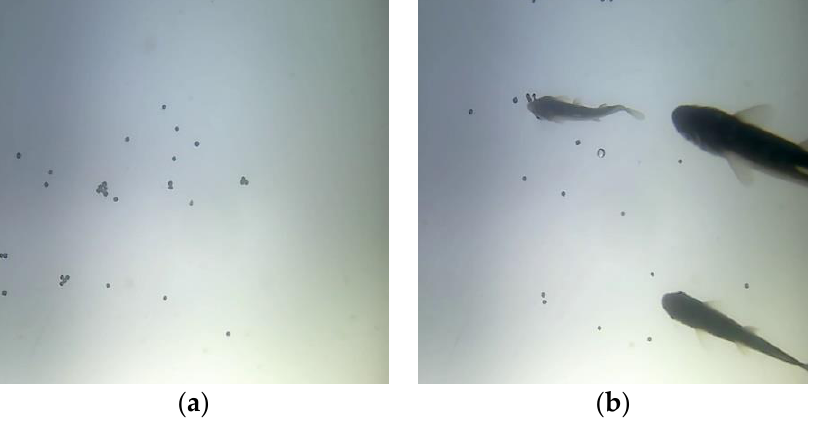
Figure 4. Images acquired from the bottom: ( a ) floating uneaten pellets; ( b ) fry feeding behavior.